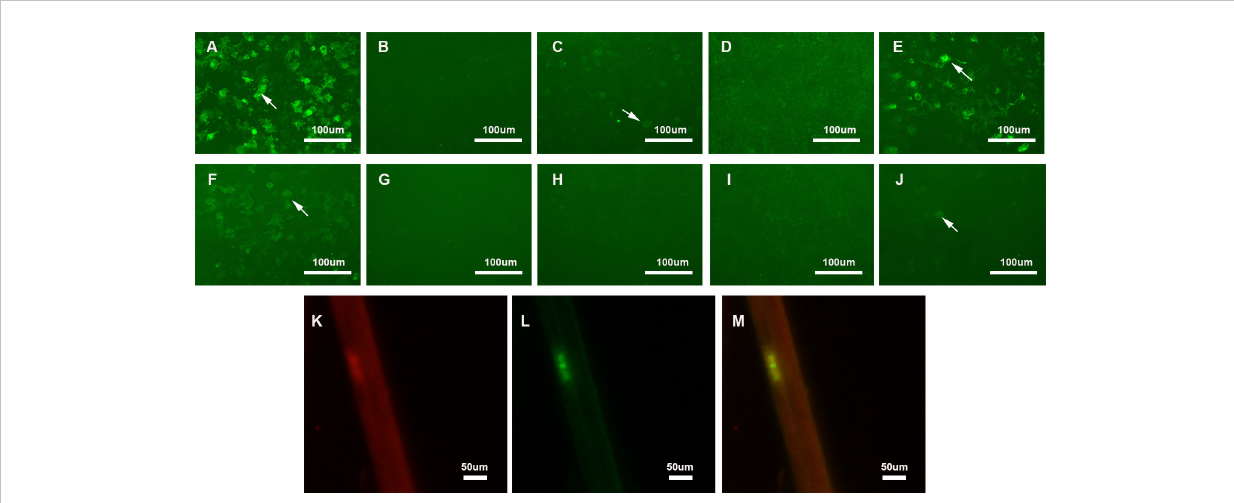
FIGURE 1 Detection of anti-NF155 antibodies. (A – E) Detection of anti-NF155 antibodies in serum. (A) 1:100 positive anti-NF155 antibodies (arrow); (B) Negative anti-NF155 IgG1 antibodies; (C) 1:10 positive anti-NF155 IgG2 antibodies (arrow); (D) Negative anti-NF155 IgG3 antibodies; (E) 1:32 positive anti- NF155 IgG4 antibodies (arrow); (F – J) Detection of anti-NF155 antibodies in CSF. (F) 1:3.2 positive anti-NF155 antibodies (arrow); (G) Negative anti- NF155 IgG1 antibodies; (H) Negative anti-NF155 IgG2 antibodies; (I) Negative anti-NF155 IgG3 antibodies; (J) 1:1 positive anti-NF155 IgG4 antibodies (arrow); (K – M) Double-immuno fl uorescence of murine teased fi bers with serum sample of the patient. Seropositive of serum from Case 1 (Red). Optimal colocalization is noted in the paranodal region. (yellow). Scale bars = 100 m m (A – H) ; Scale bars = 50 m m (K – M) NF155, neurofascin-155; CSF, cerebrospinal fl uid; NF186,